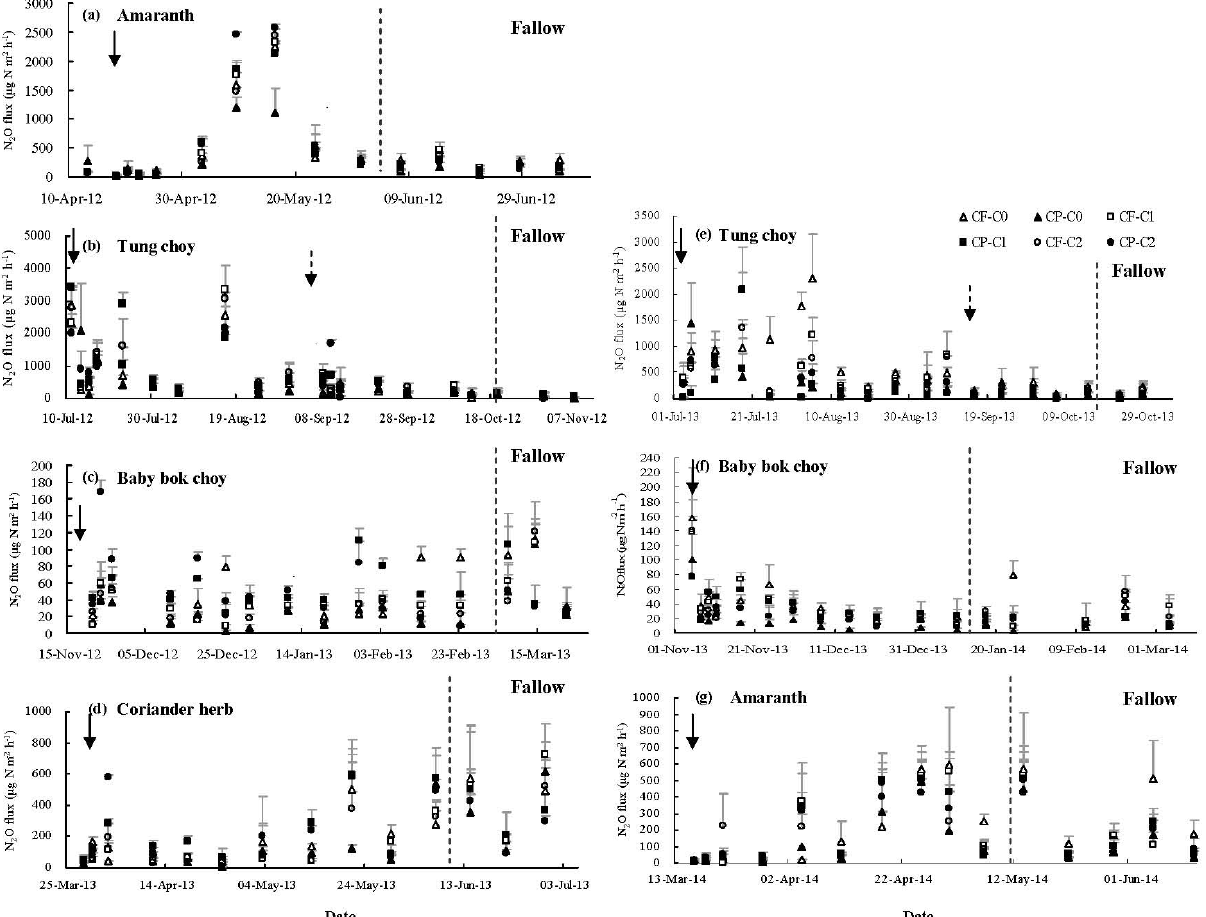
Figure 2. Dynamics of soil N 2 O emission fluxes under different treatments in vegetable fields with seven consecutive vegetable crops from 2012 to 2014 in southeastern China. The solid and dashed arrows indicate basal fertilization and topdressing, respectively. The dashed vertical line in each subfigure separates the vegetable growing and fallow periods. The bars indicate the standard error of the mean ( + SE) for the three replicates of each treatment. See Table 2 for treatment